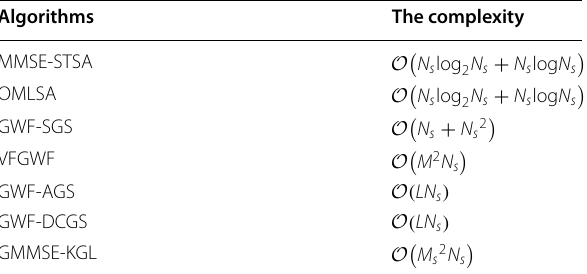
Table 15 The computational complexity of different methods Algorithms The